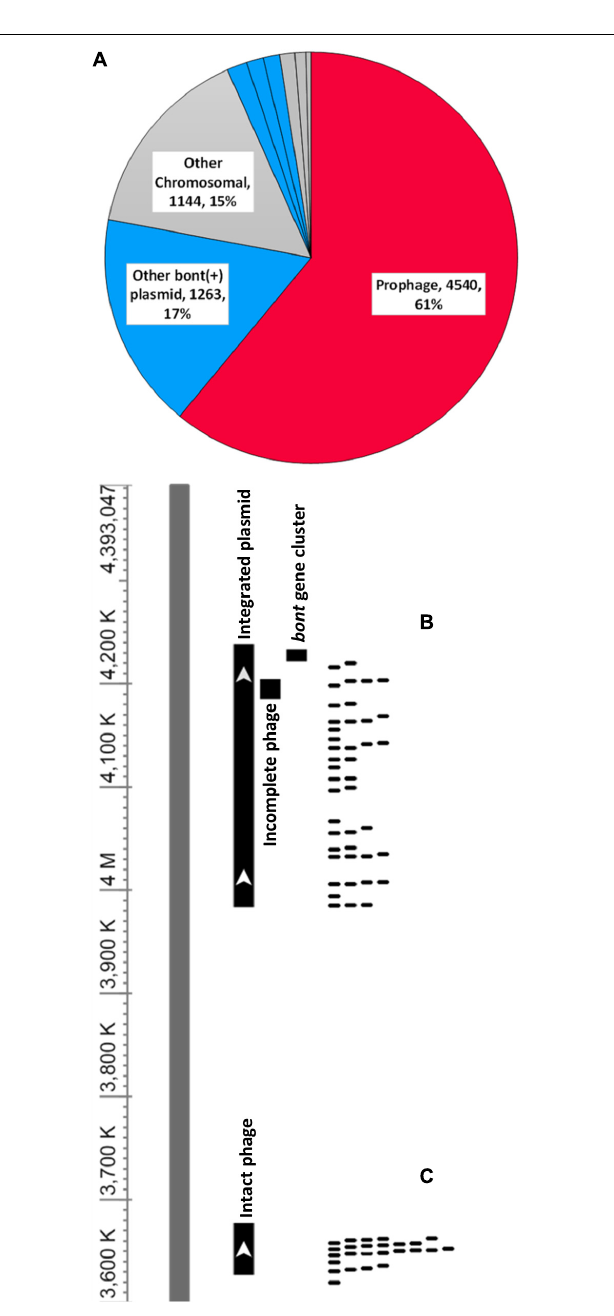
FIGURE 5 | Botulinum neurotoxins are not targets of CRISPR spacers. (A) Pie chart showing 7,005 spacer–protospacer pairs from 43 closed genomes categorized by genomic localization. Individual sites are detailed in Table 3 . Genomic sites 1–7 are defined as in Figure 3 . Boundaries for each genome are provided in the Supplementary File 5 . Prophage refers to any protospacer present within a chromosomal prophage region. Other bont (+) plasmid to any bont (+) plasmid protospacers falling outside the defined sites S5–7 and other chromosomal to any protospacers outside of a predicted phage or defined sites S1–4 ( Figures 3B,C ). (B,C) Protospacers occur at a higher density in prophage and plasmids relative to the chromosome. Mapping spacers to the closed genome of C. sporogenes CDC 1632 revealed through protospacer matches, both prophage associated regions and an integrated bont (+)